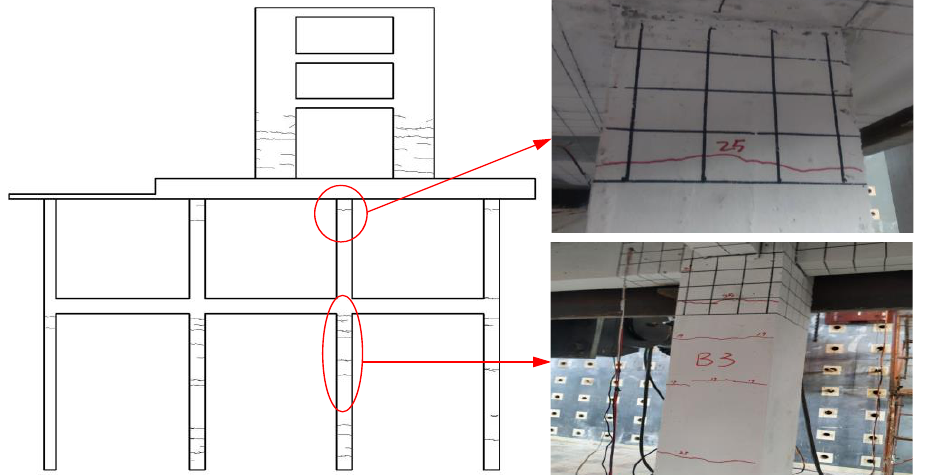
Figure 15. 7I-MCE damage condition. 8I-MCE damage condition: The columns on the first floor were seriously damaged, with many long cracks appearing, and new cracks appearing at the embedded ends of the columns at the bottom. There were more horizontal cracks on the top of the second-floor columns, but no cracks were found in the transfer slabs. There were more new cracks in the shear wall and the original cracks continued to develop, as shown in Figure 16.